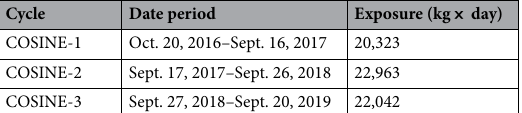
Table 2. Three-year cycles of COSINE-100 data for the DAMA-like method 15,16 .